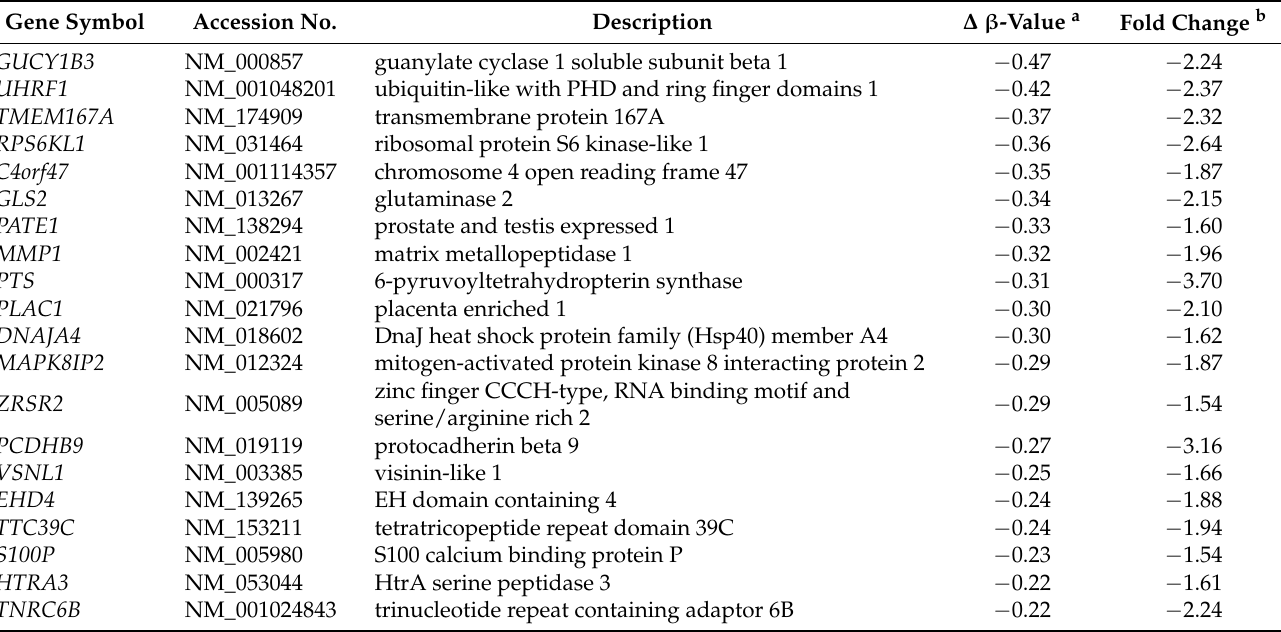
Table 1. Top twenty hypomethylated genes in the MCF-7/tamR